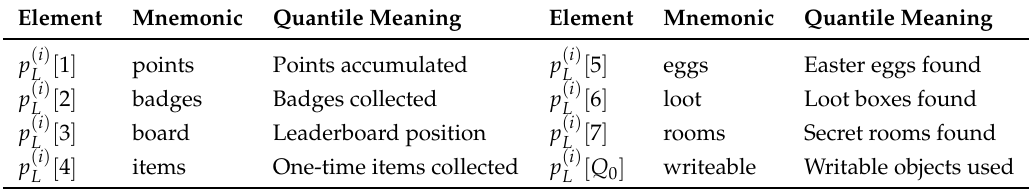
( i ) [ 5 ] eggs Easter eggs found L ( i ) [ 6 ] loot Loot boxes found L ( i ) [ 7 ] rooms Secret rooms found L ( i ) [ Q ] writeable Writable objects used 0 L